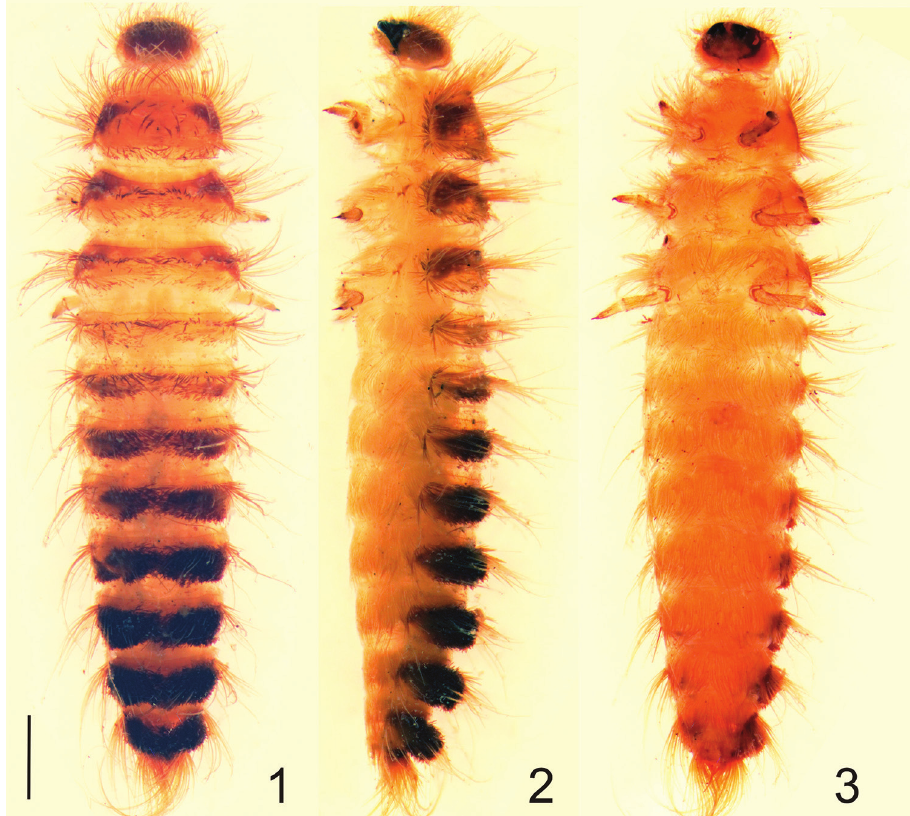
Figures 1–3. Mature larva of Megatoma (s. str . ) undata (Linnaeus, 1758). 1 Dorsal view 2 Lateral view 3 Ventral view. Scale bar 0.1